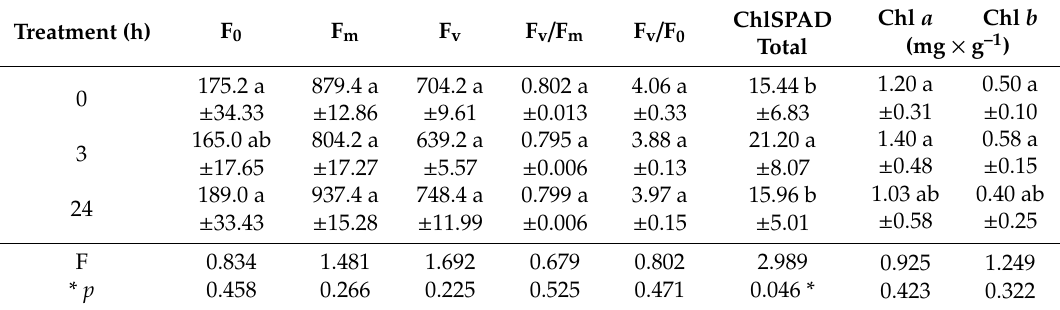
Table 5. Chlorophyll a fluorescence and chlorophyll content of triticale ( × Triticosecale Wittm. ex A.Camus) plants grown from grains irradiated with a helium-neon (He-Ne) laser by 3 and 24 h; mean ± SD (n = 10) values marked with di ff erent letters di ff er statistically according to Tukey’s test at * p ≤ 0.05.